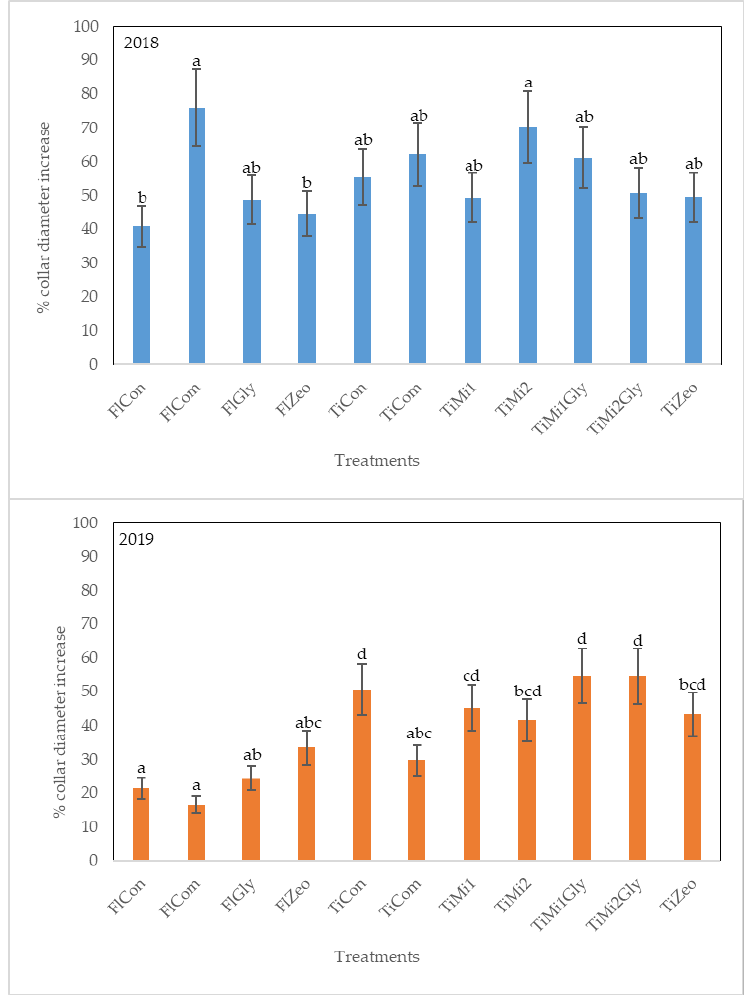
Figure 1. Stem growth expressed as % collar diameter increase during growing season. Data are the mean of 23 replicates. The letters on the columns show significant differences between the treatments according to ANOVA, least significant difference (LSD) analyses at p -value threshold ≤ 0.05. FlCon: flat soil, without any addition; FlCom: flat soil, with addition of compost (130 t ha − 1 ); FlGly: flat soil, with addition of glycine-betaine; FlZeo: flat soil, with addition of zeolite; TiCon: soil tilled to form raised ridges of about 50 cm in rows, without any addition; TiCom: soil tilled to form raised ridges of about 50 cm in rows, with addition of compost (80 t ha − 1 ); TiMi1: soil tilled to form raised ridges of about 50 cm in rows, with addition of microbial consortium 1; TiMi2: soil tilled to form raised ridges of about 50 cm in rows, with addition of a microbial consortium 2; TiMi1Gly: soil tilled to form raised ridges of about 50 cm in rows, with addition of a microbial consortium 1 and addition of glycine-betaine; TiMi2Gly: soil tilled to form raised ridges of about 50 cm in rows, with addition of a microbial consortium 2 and addition of glycine-betaine; TiZeo: soil tilled to form raised ridges of about 50 cm in rows, with addition of